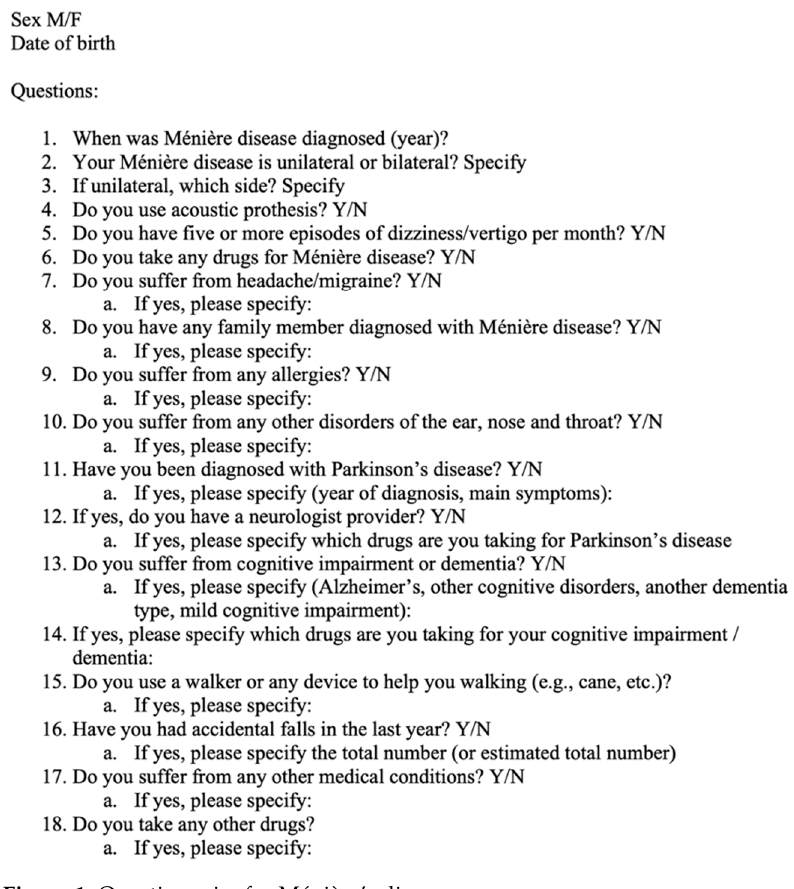
Figure 1. Questionnaire for Ménière’s disease.